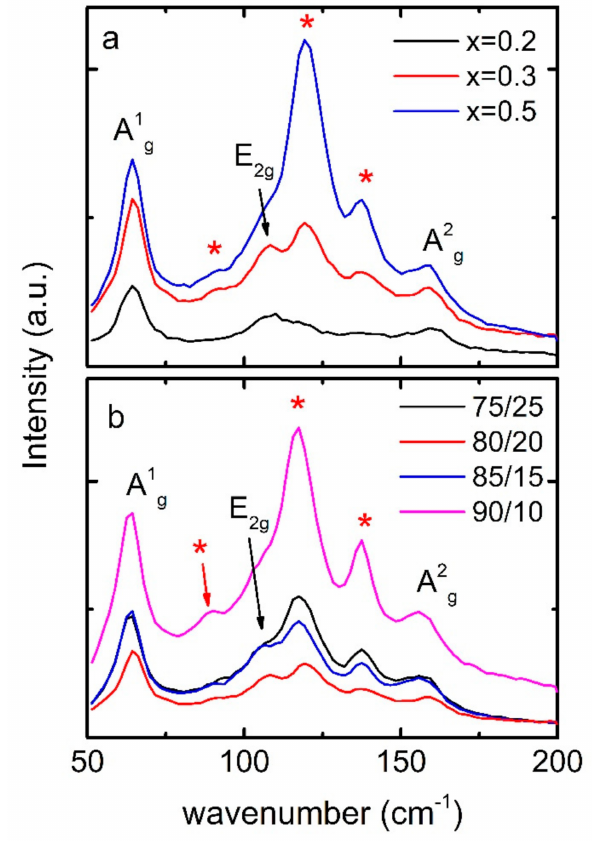
(cid:16) (cid:17) m BST = 80 , with various Bi dopings. Peaks pointed m ABS 20